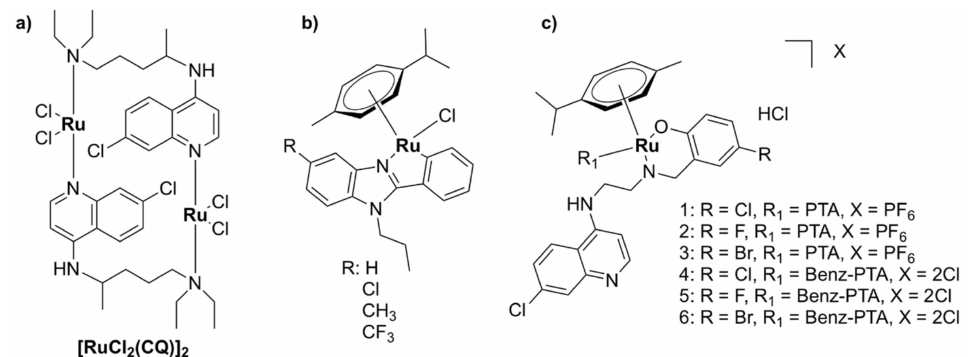
Figure 22. Chemical structures of ruthenium complexes with antiplasmodial activity. ( a ) [RuCl 2 (CQ)] 2 , ( b ) cyclometallated Ru(II) complexes of 2-phenylbenzimidazoles, and ( c ) PTA-derived ruthenium(II) quinoline